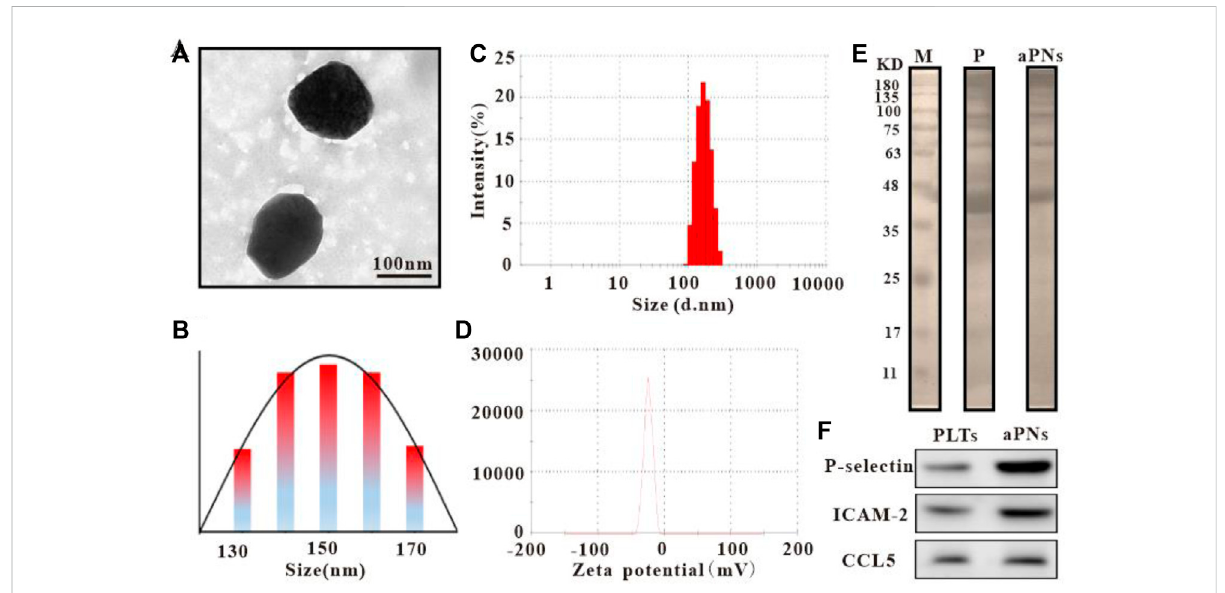
Characteristics of PLTm nanovesicles. (A) PLTm nanovesicles observed under TEM, scale bar: 100 nm. (B) TEM size distribution of PLTm nanovesicles. (C) DLS of PLTm nanovesicles. (D) Zeta potential of PLTm nanovesicles. (E) SDS-PAGE protein analysis of PLTs and activated PLTm